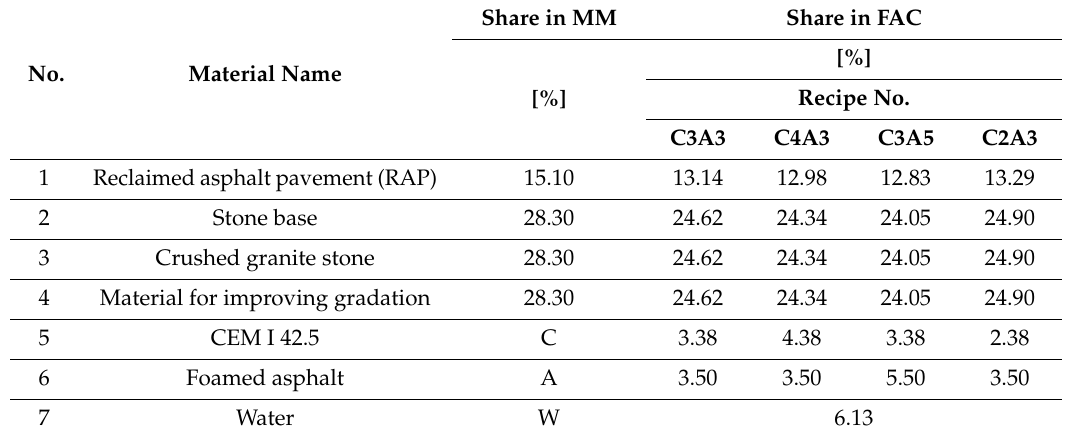
Table 2. Composition of FAC